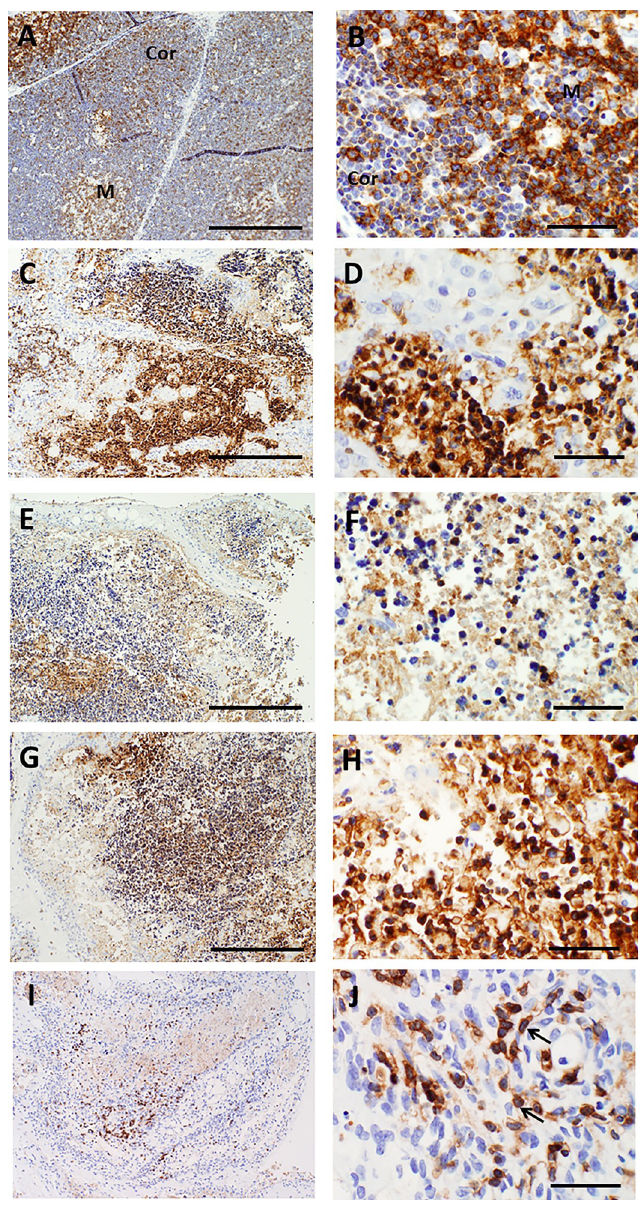
Fig 13. β F1 immunostaining in thymus slices as a function of time in culture. A, B. On day 0, a subset of immature T cells in the cortex (Cor) and essentially all of the medullary thymocytes react strongly with β F1 antibody that is specific for the β chain of the αβ T cell receptor. Higher magnification (B) shows strong brown positive membrane reactivity; M denotes medulla. C, D. Reactivity with antibody remains strong on day 7, however the specific membrane staining is lost and reactivity is primarily with cellular debris in medullary areas. Similar loss of membrane immunostaining and reactivity primarily with residual thymocyte debris is seen on days 9 (E, F), 12 (G, H) and 21 (I, J), but cells with intact membranes can be detected (see arrows in J). Bar represents 500 um in panels A, C, E, G, and I and 50 um in B, D, F, H, and